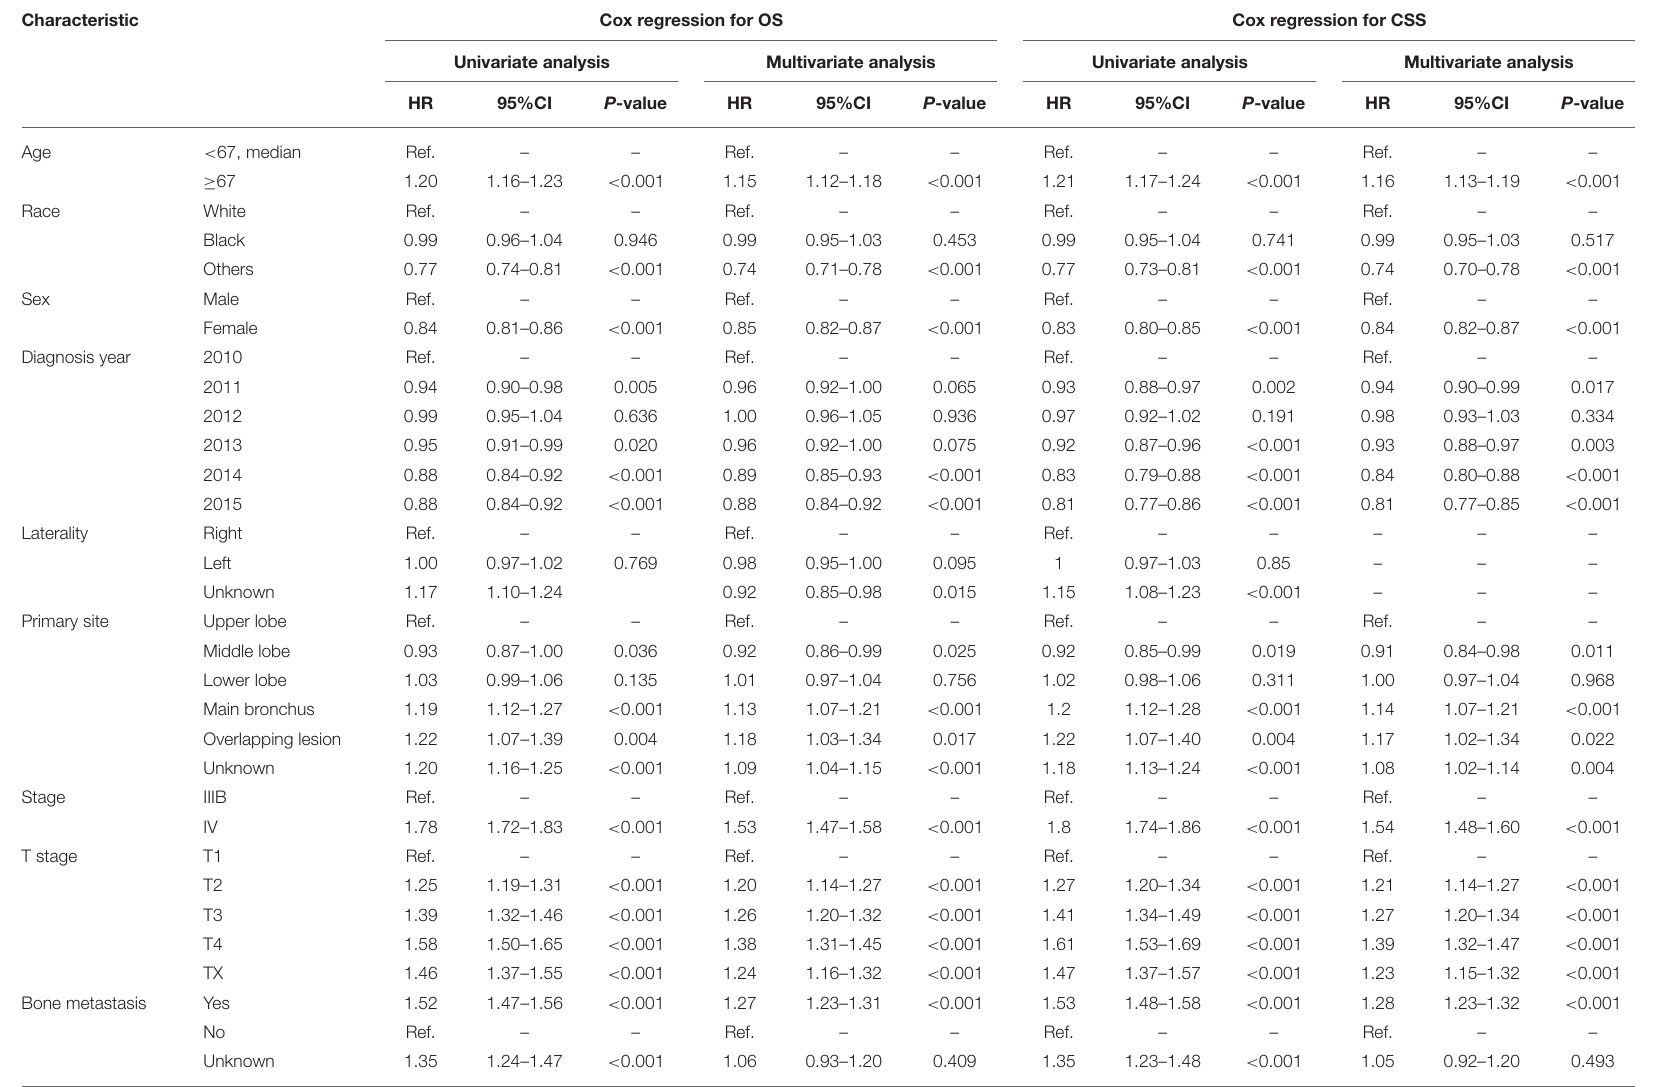
TABLE 2 | Univariate and multivariate Cox regression analysis for overall survival (OS) and lung cancer-specific survival (CSS) in all patients with